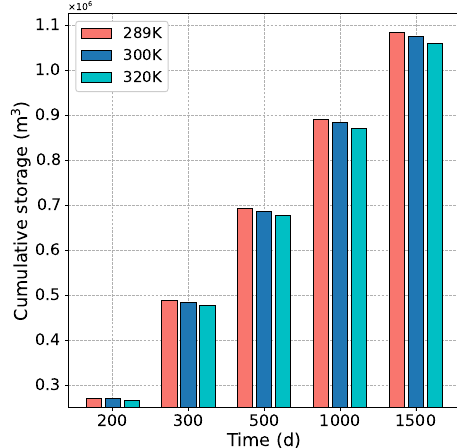
Figure 16. Cumulative production comparison.